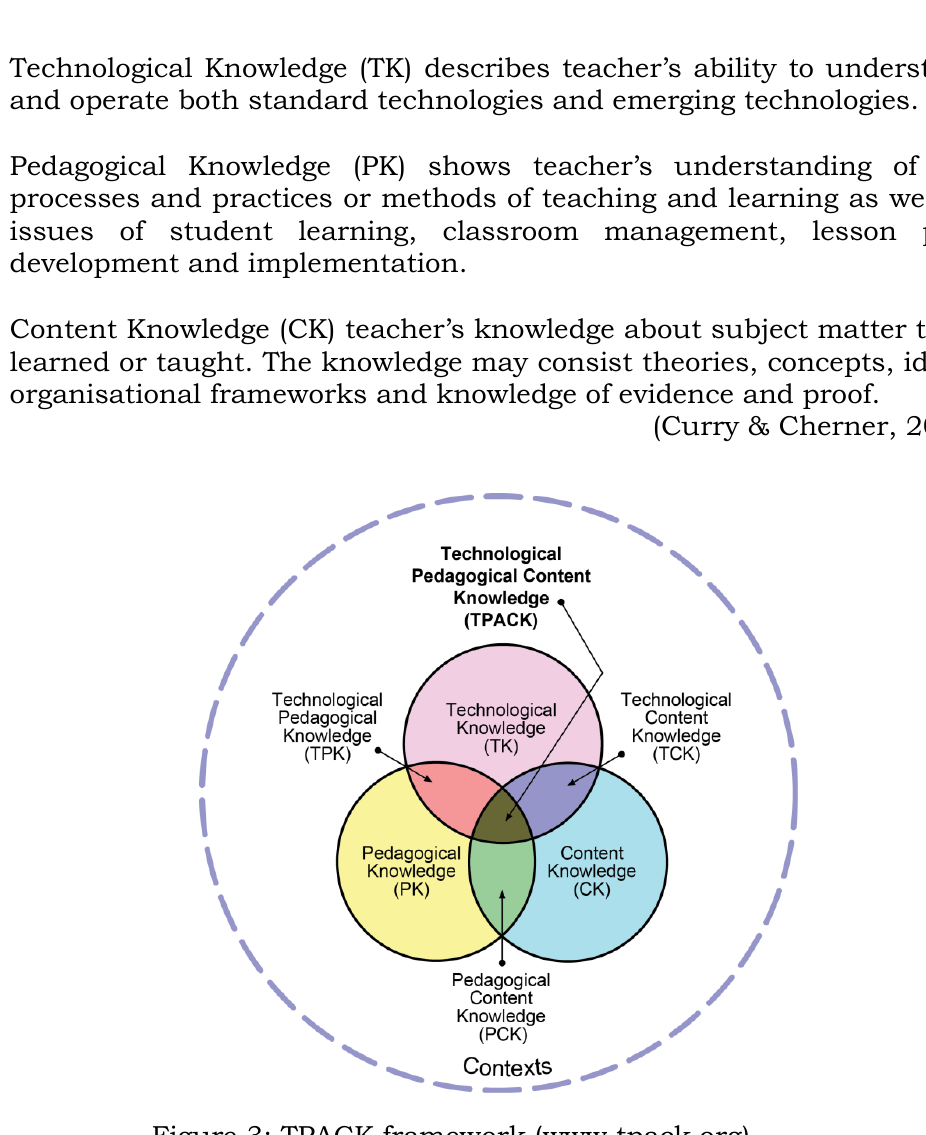
Figure 3: TPACK framework